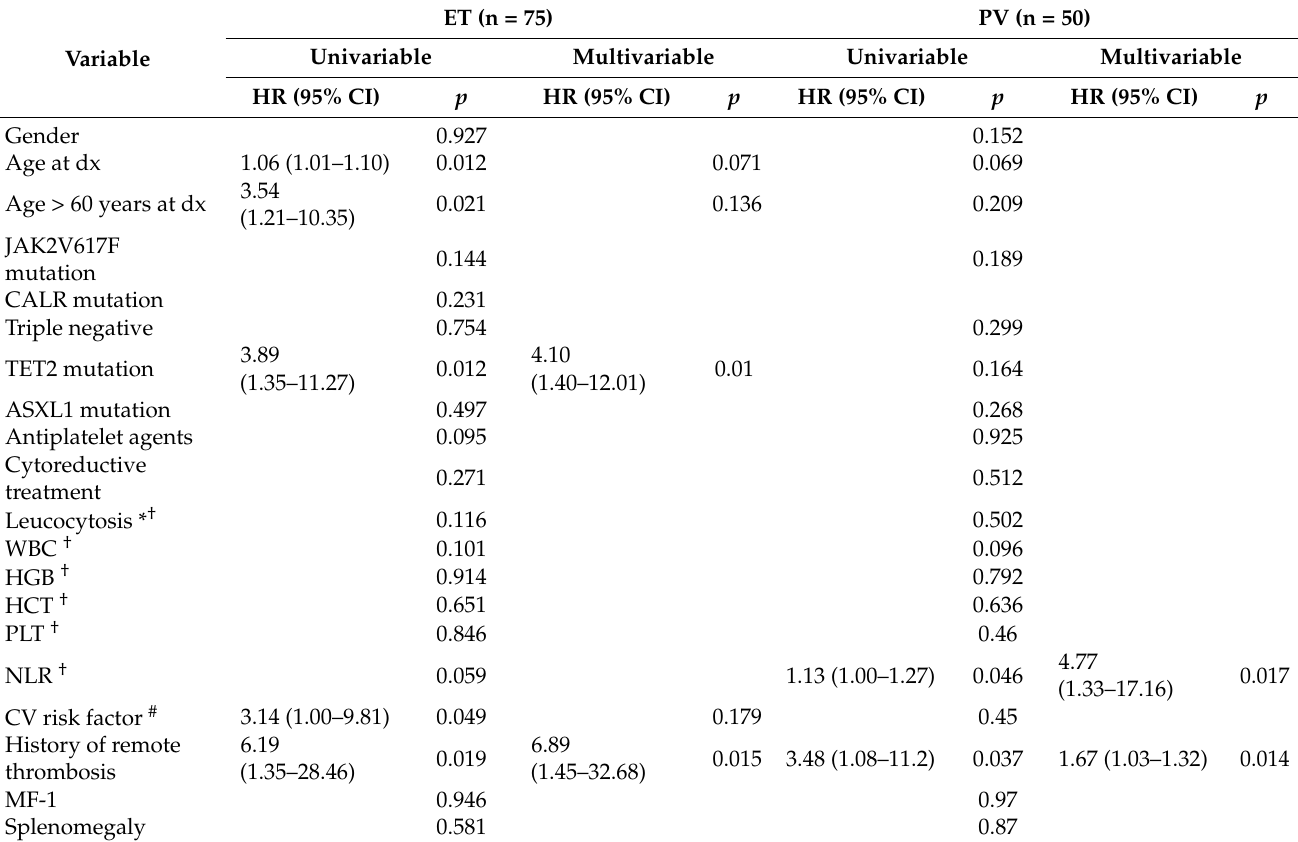
Table 3. Univariate and multivariate analysis of risk factors for thrombosis in ET and PV patients.